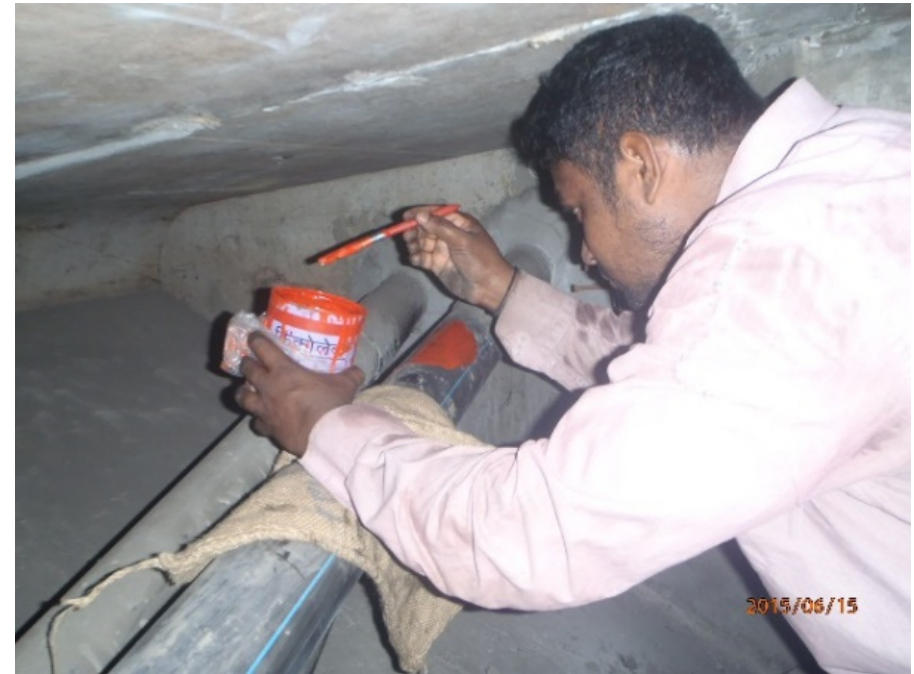
Figure 14. Marking suspect locations along post-tensioning elements.